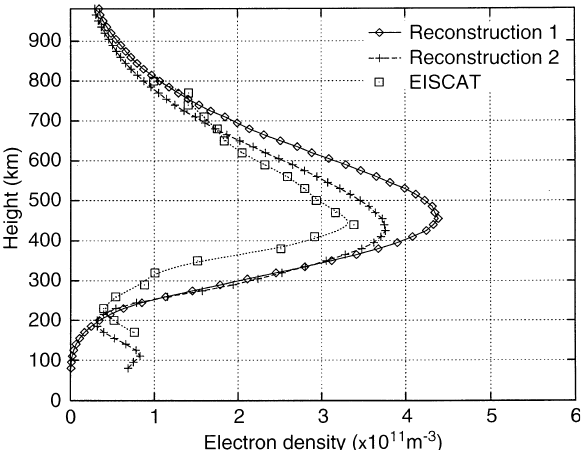
Fig. 5. Profiles through the tomographic images for a satellite pass at 20:58 UT on 23 March 1992 and EISCAT SP-UK TOMO data